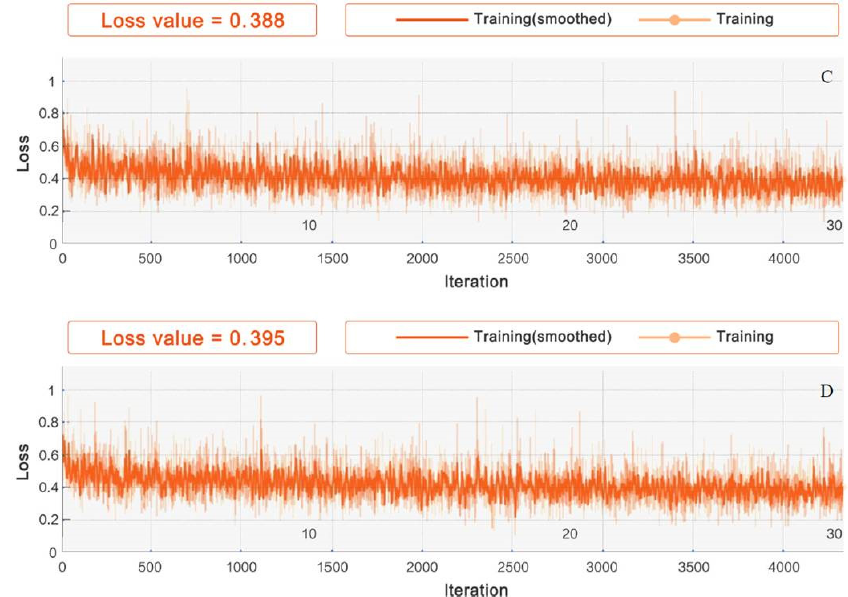
Figure 4. Iterative processes of di ff erent activation functions in IGRNet: ( A ) is the loss change of the ReLU function, ( B ) is the loss change of the LeakyReLU function, ( C ) is the loss change of the ELU function, and ( D ) is the loss change of the ClippedReLU function.